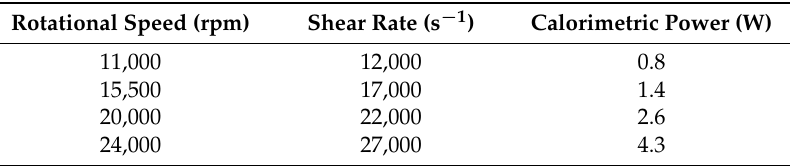
Table 3. Overview of the settings used for the rotor–stator mixer, the calorimetric powers, and the calculated shear